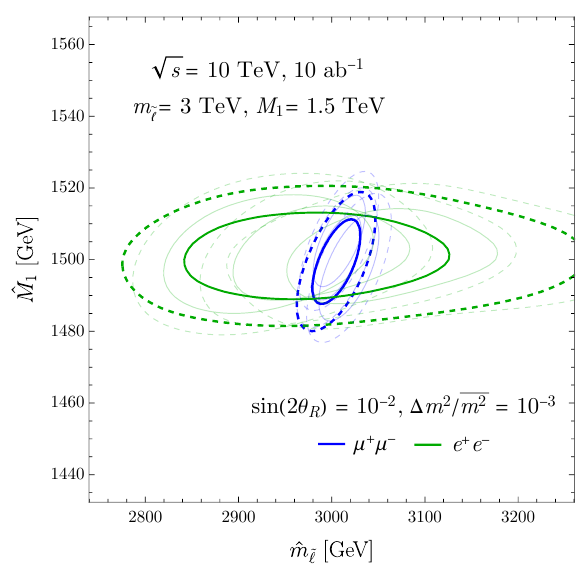
Figure 12. Contours of ∆ NLL evaluated for the various toy datasets, as well as the average ∆ NLL for ten such toys, both for the µ + µ − (blue) and e + e − (green) channels, at 68% (solid) and 95% (dashed)